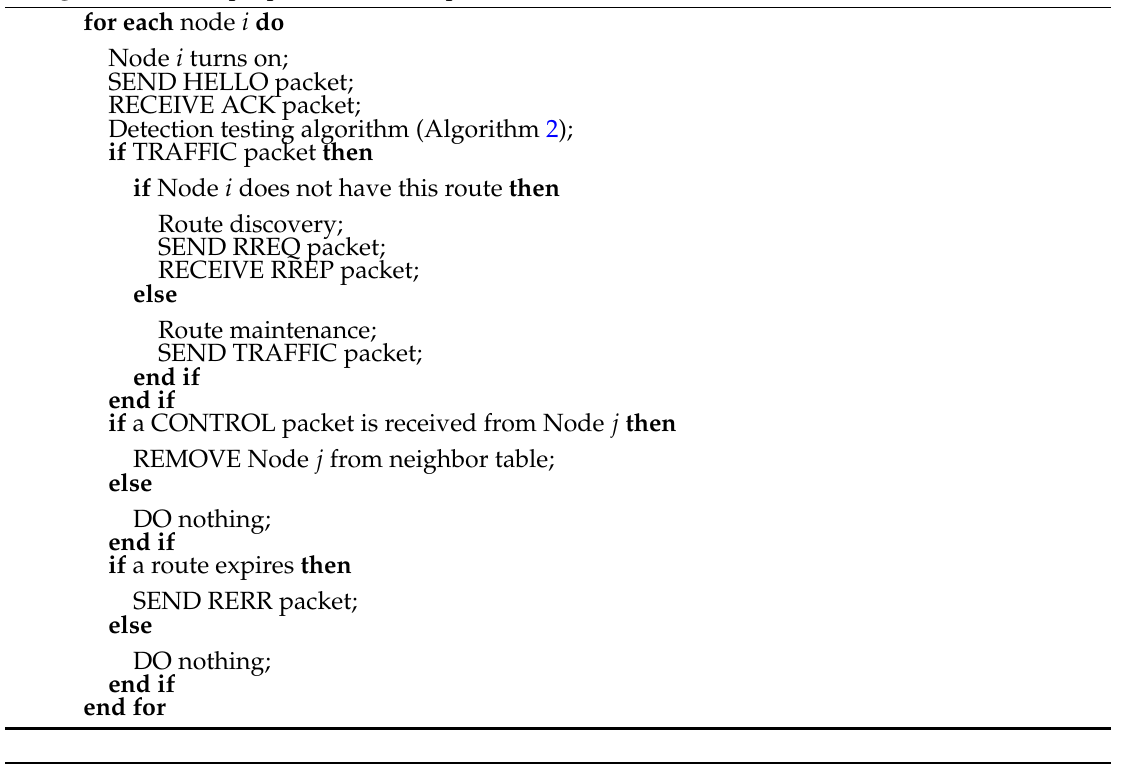
Algorithm 4: The proposed modified protocol: MPH-M. for each node i